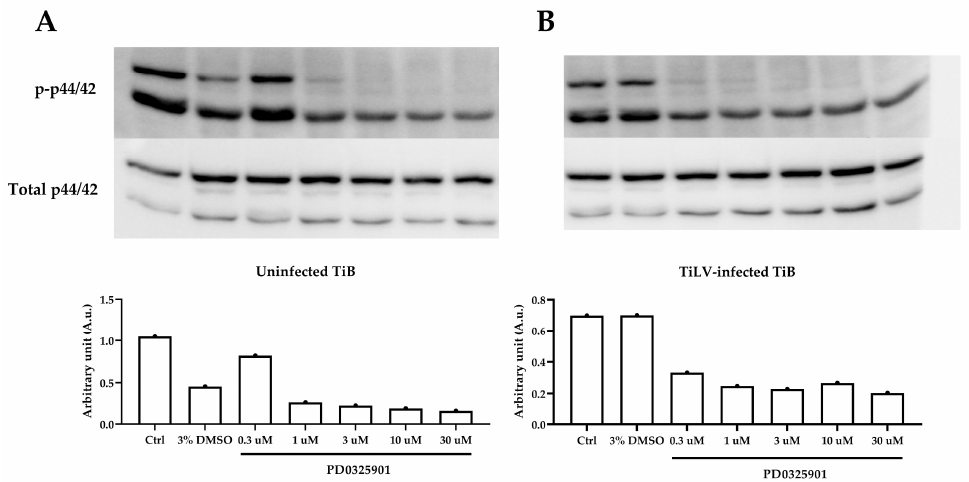
Figure 4. Evaluation of p-ERK (p-p44/42) in ( A ) the uninfected TiB cells and ( B ) TiLV-infected cells using PD0325901 (PD) at concentrations of between 0.3–30 µM. The band intensity of p-p44 was completely faded when the TiB cells were incubated with between 10–30 µM of PD.